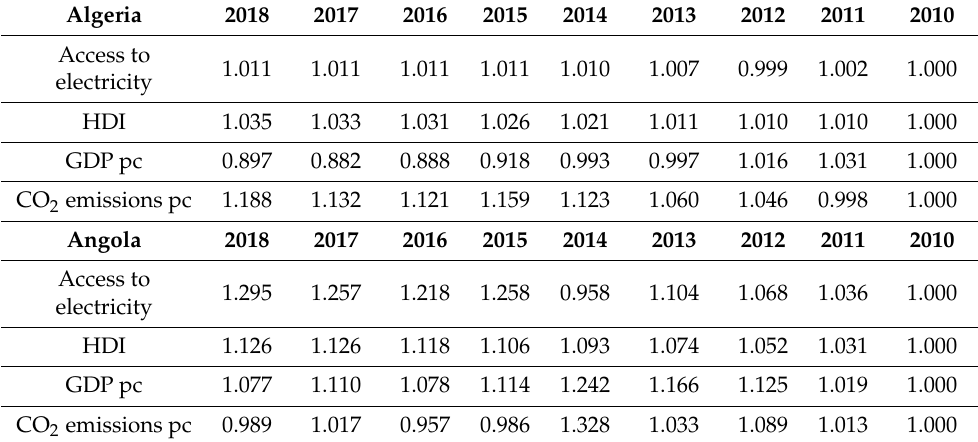
Table 2. Time series standardized against their initial values for two selected African countries. Source: own calculated. Algeria